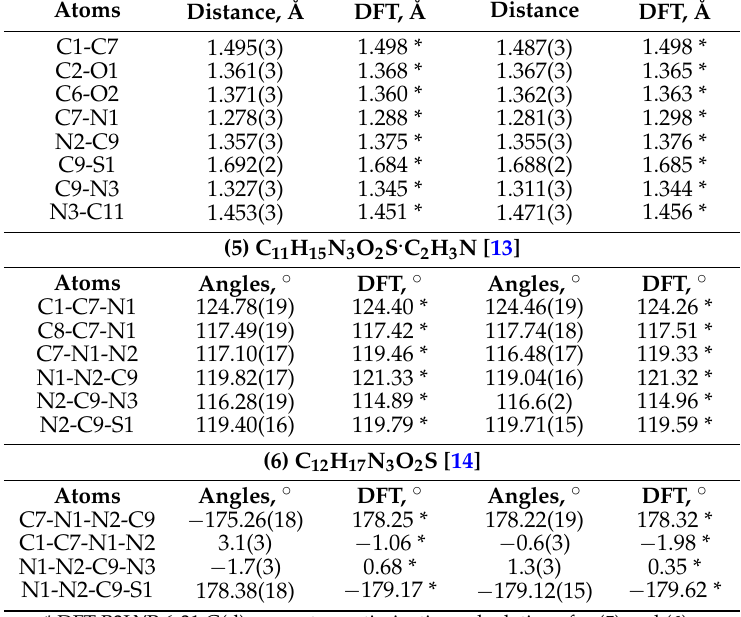
Table 6. Hydrogen bond interactions for ( 5 ) and ( 6 ) [Å and °].